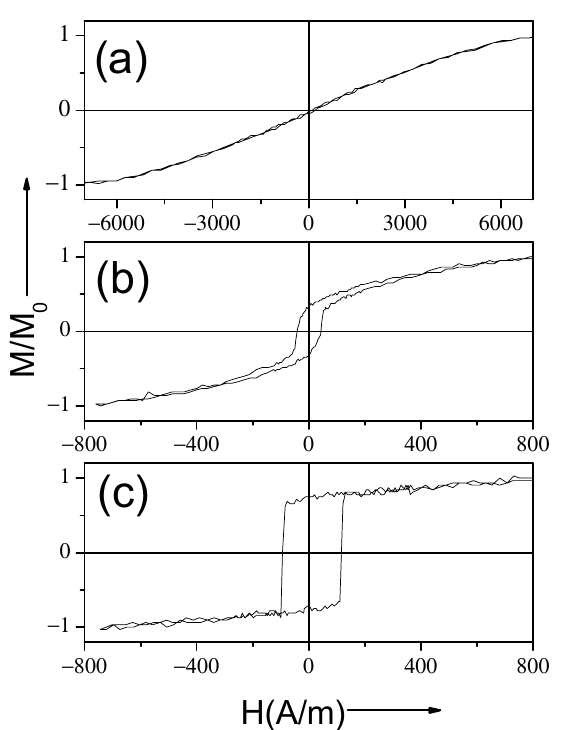
Figure 3. Hysteresis loops of as-prepared ( a ), and subjected to chemical etching for 35 min ( b ) and 50 min ( c ) Co 68.5 Si 14.5 B 14.5 Y 2.5 microwires, adapted from [66].